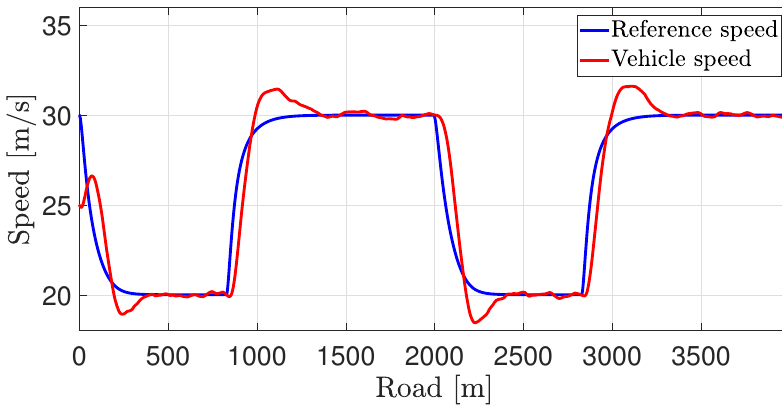
Figure 10. Reference and real speed.